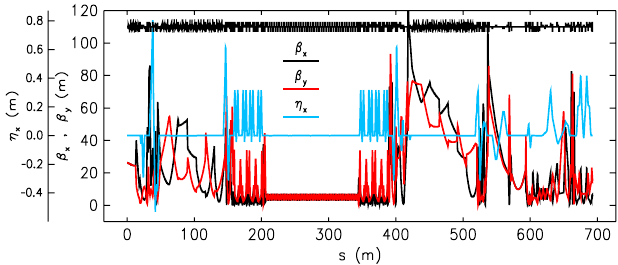
FIG. 10. Optics functions and dispersion for the recirculating linac including collimation and spreader.